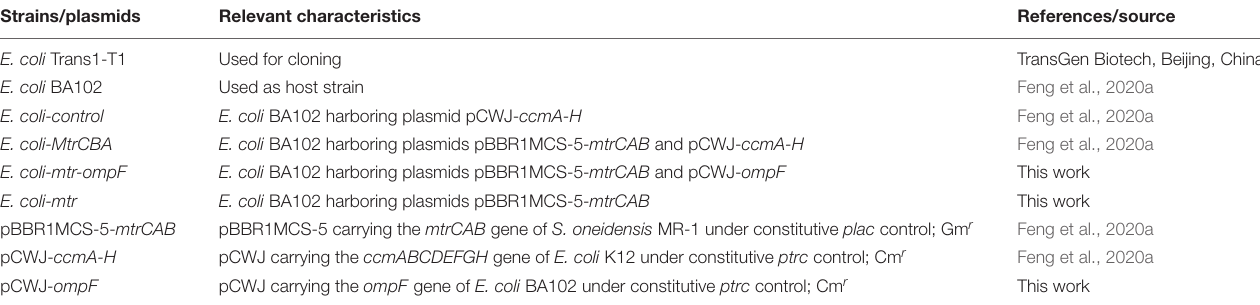
TABLE 1 | Strains and